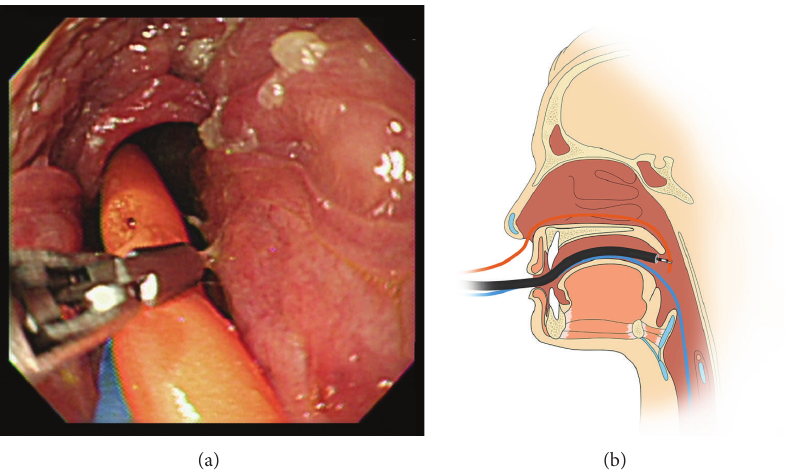
Figure 1: Endoscopic hands-off technique for the repositioning of an ENBD tube. (a) The distal end of a carrier tube was grasped by a rat- tooth forceps under direct endoscopic vision at the oropharynx. (b) Schematic representation of grasping the carrier tube by a rat-tooth